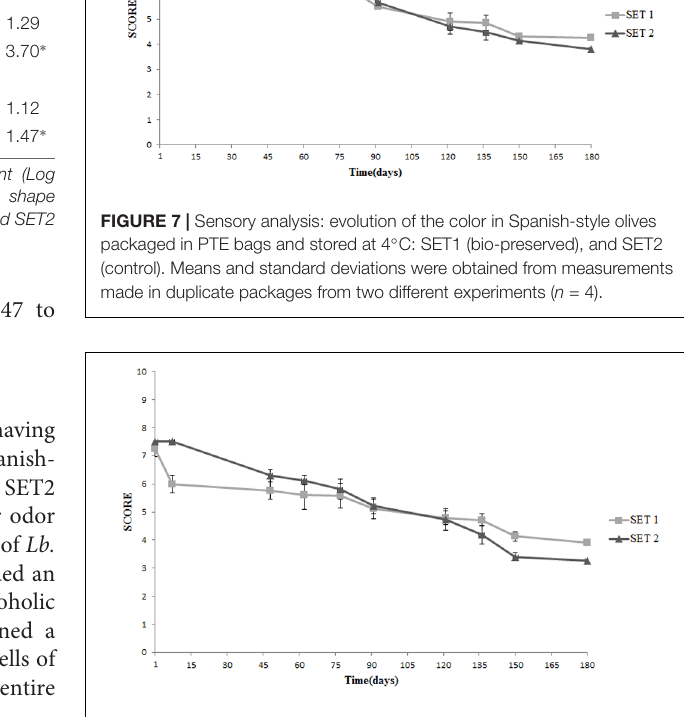
FIGURE 8 | Sensory analysis: evolution of the odor in Spanish-style olives packaged in PTE bags and stored at 4 ◦ C: SET1 (bio-preserved), and SET2 (control). Means and standard deviations were obtained from measurements made in duplicate packages from two different experiments ( n = 4).